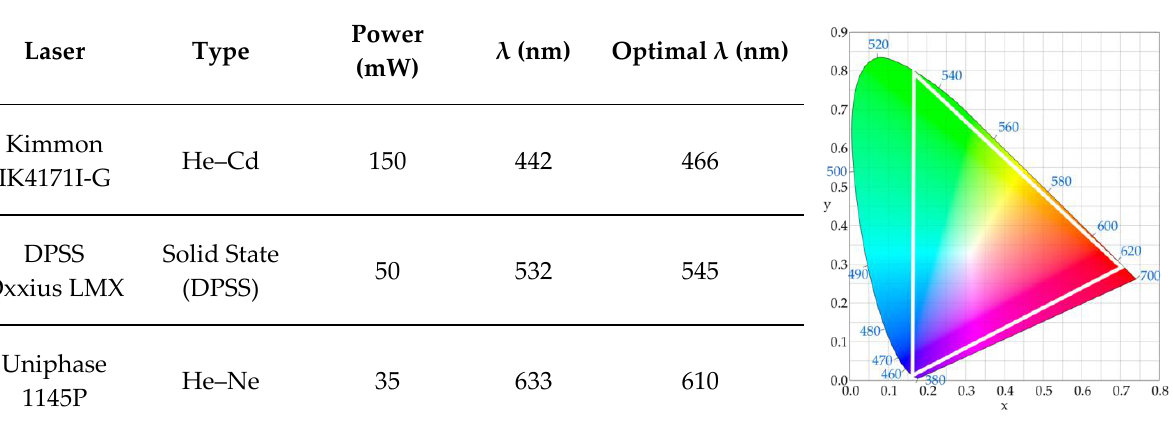
Figure 1. Main characteristics of the lasers used in the recording setup, together with the optimal λ for color reproduction stated in [16]. CIE diagram with the representation of the color reproduction area obtained with the three lasers.